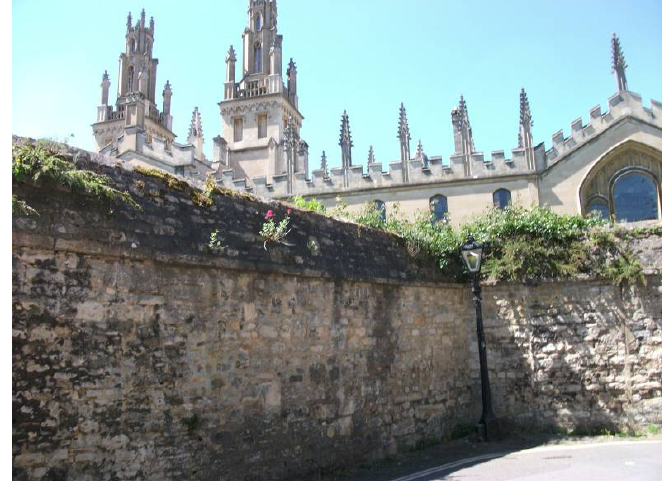
Figure 5. Vegetation colonizing the top of old walls at the Queen’s College grounds.